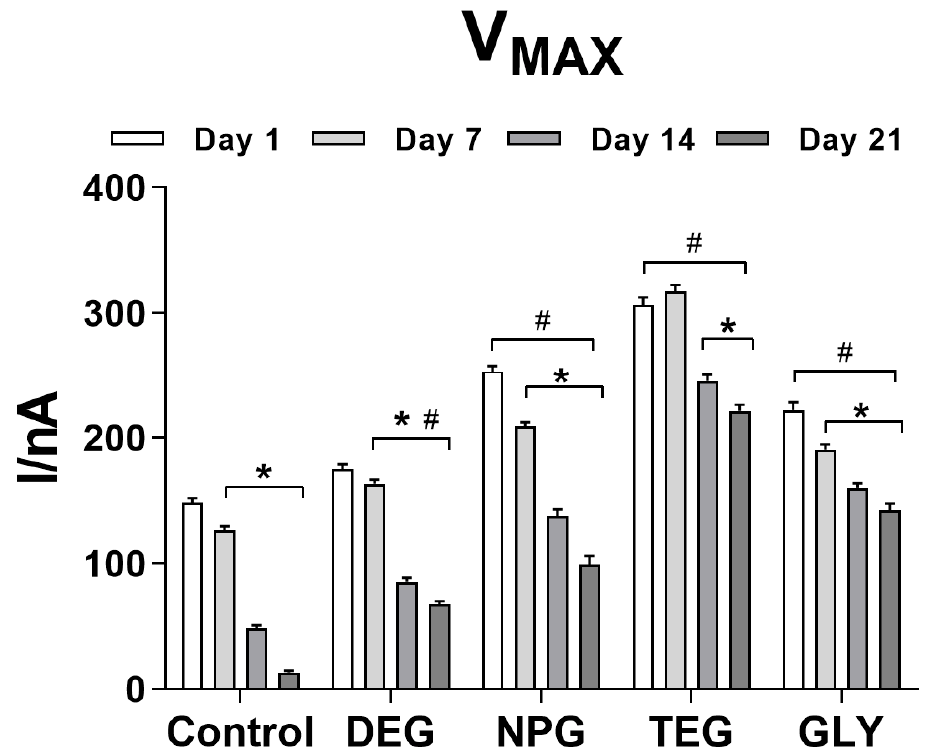
Bar plot of the variation of V MAX for di ff erent biosensor designs (n = 4): Pt c / PPD / PEI(1%) 2 / GlutOx 5 / Glycol(0.1%). Pt c : Pt cylinder 1 mm long; GlutOx: L-glutamate oxidase; PPD: ortho-phenylenediamine polymer; PEI: polyethyleneimine, DEG: diethylene glycol, NPG: neopentyl glycol, TEG: triethylen glycol, GLY: glycerol. The subscript number represents the number of dips and in brackets, the concentration of the glycol. Values are expressed as mean ± SEM. * p < 0.001 vs. Day 1 of the respective group. # p < 0.001 vs. control design.